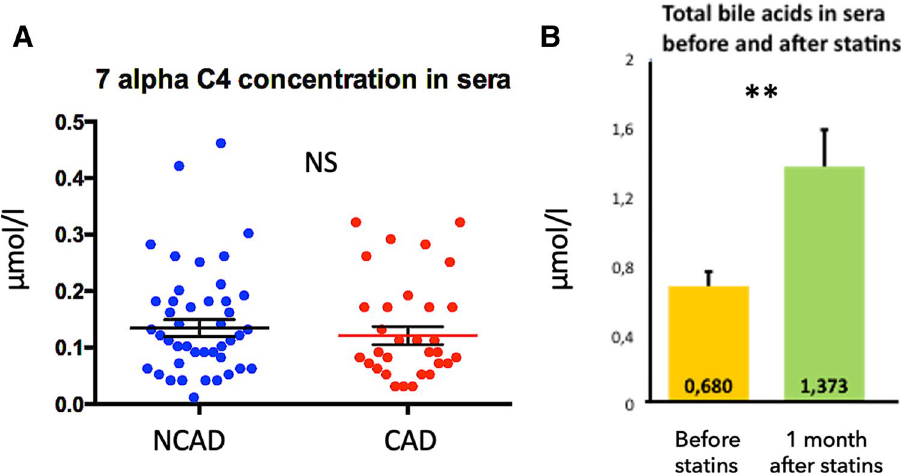
Figure 5. ( A ) Concentrations (µmol/l) of 7 alpha C4, a liver metabolite reflecting the daily hepatic bile acid synthesis in sera in the two study samples. ( B ) Comparison of total bile acids concentrations in a subset of 17 patients with coronary artery disease after 1 month of statin therapy. NCAD = non-coronary artery disease; CAD: = coronary artery disease. ** P < 0.01. Image credit: Graphpad 6.0, https:// www. graph pad. com/ scien tific- softw are/